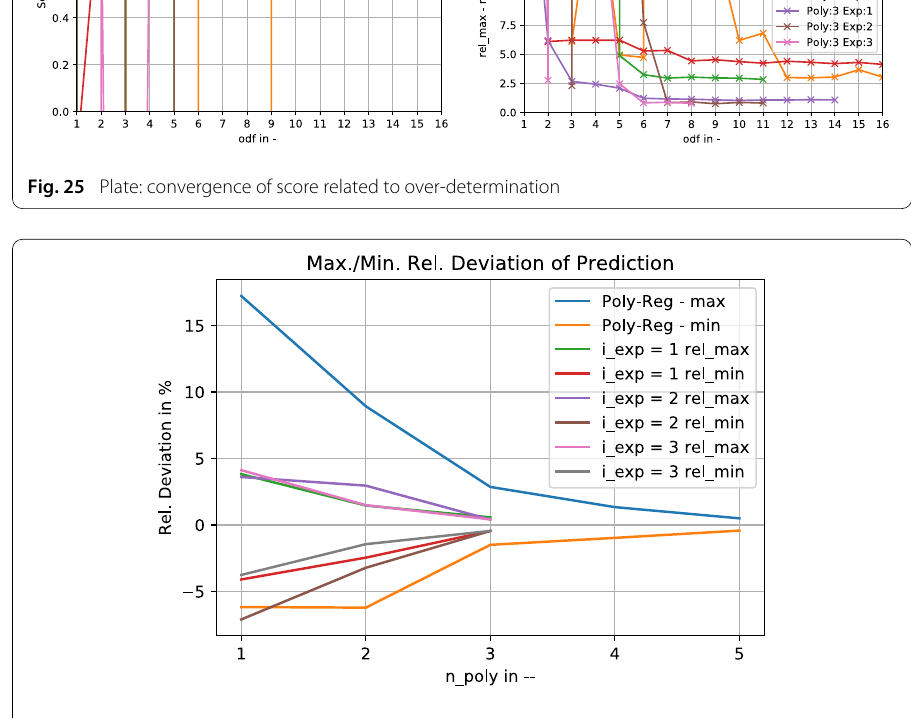
Fig. 26 Rel. deviation for plate for different model